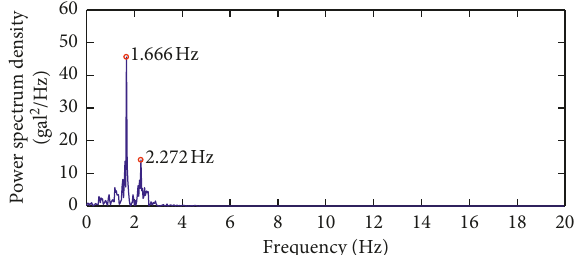
Figure 15: Spectrum diagram of the signal after EEMD denoising.